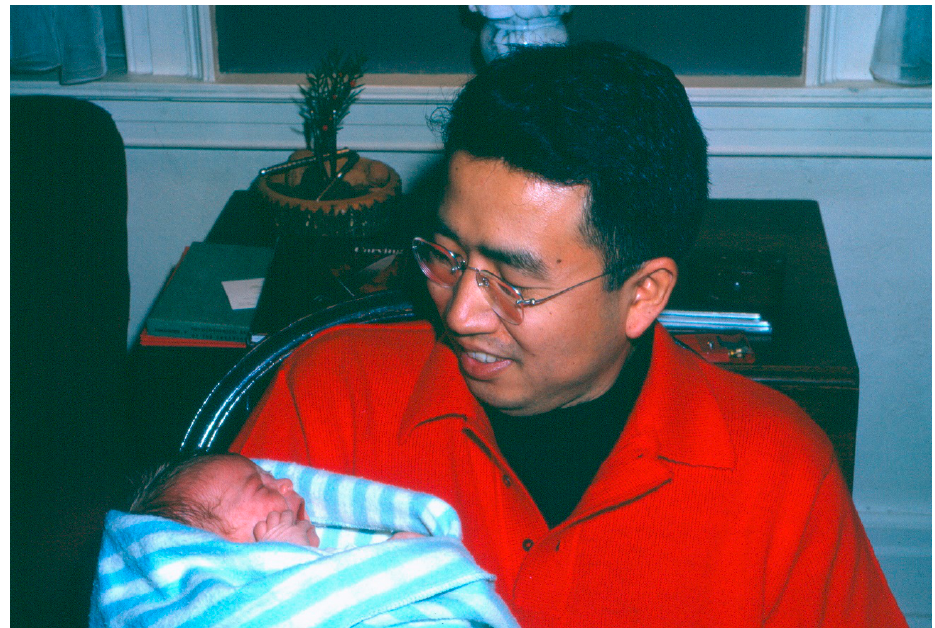
Figure 2. Taro was a frequent visitor to our farm a few miles west of Rochester. Here, he holds Kari, our first-born child. I’m not sure, of course, but he does look as if he might be telling her that someday she too may be a geologist. If so, he was